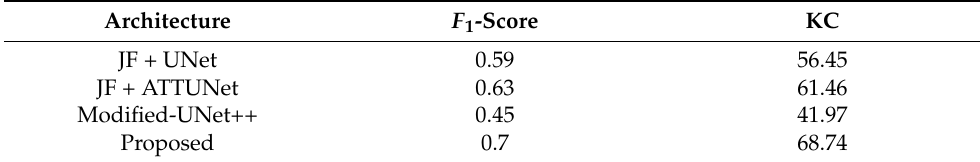
Table 6. F 1 -score and KC for CDD